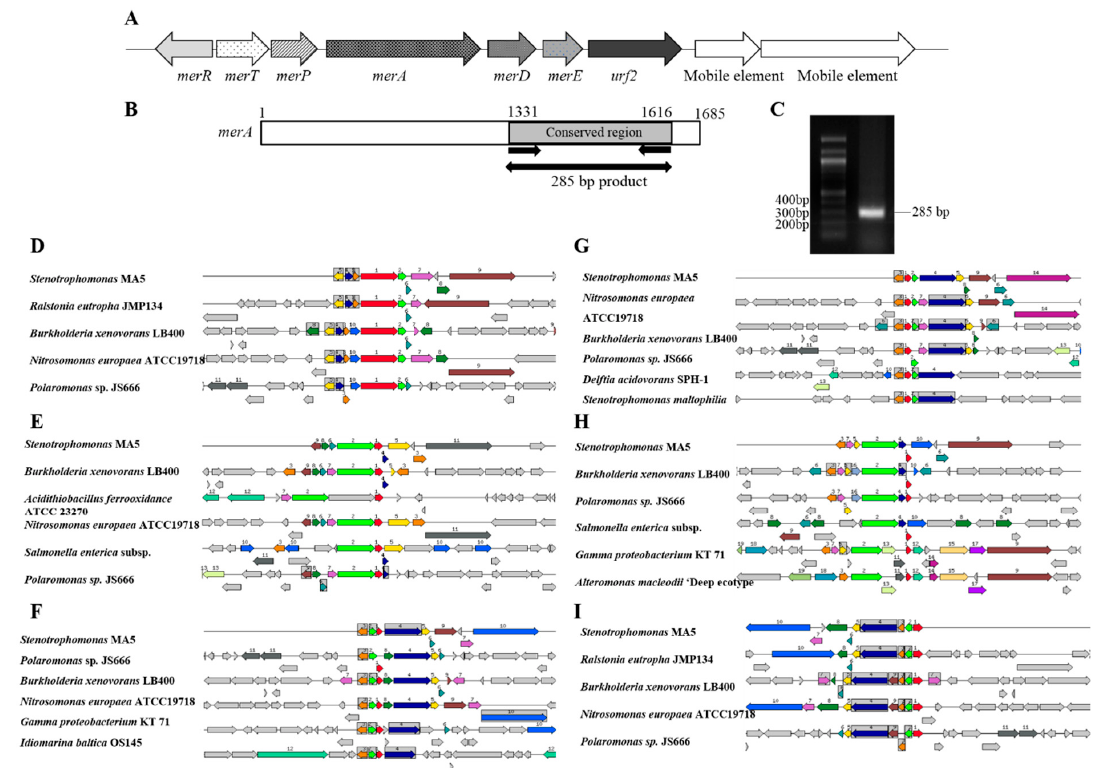
Figure 3. Presence of mer determinants in Stenotrophomonas sp. strain MA5 ( A ) A schematic showing genes present in mer operon of MA5 and their orientation on the chromosome. ( B ) PCR amplification of a conserved region of merA using primers A1s-n.F and A5-n.R and presence of the amplified band on the agarose gel ( C ). ( D – I ) Shown are the chromosomal regions of mer operon genes in Stenotrophomonas sp. strain relative to 5 other organisms. The graphic is centered on the focus genes merA , merD, merP, merT , merE and merR respectively, red in color and numbered 1. Sets of genes with a similar sequence are grouped with the same number and color. Genes whose relative position is conserved in other species are functionally coupled and share gray background boxes.